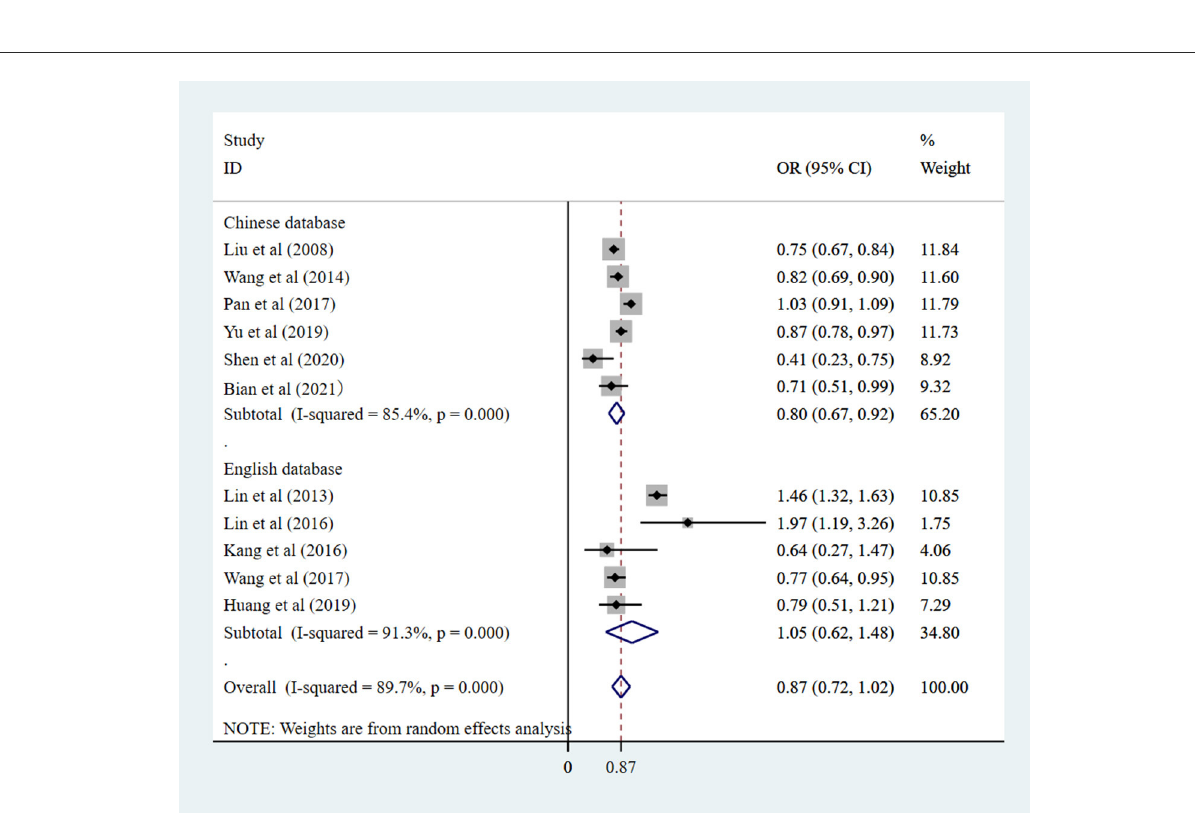
FrontiersinPublicHealth